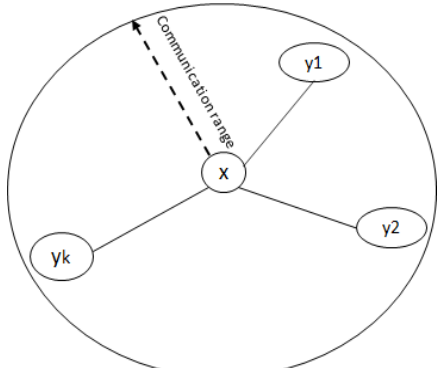
Figure 3. Neighbors and communication